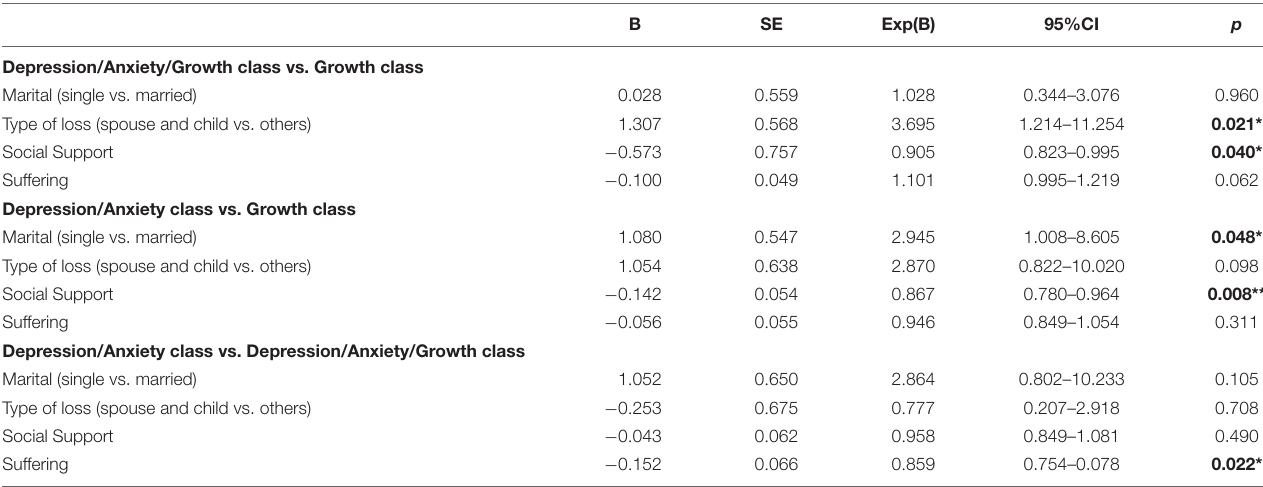
FIGURE 1 | Estimated probability for the three classes. TABLE 3 | Multinominal logistic regression predicting class